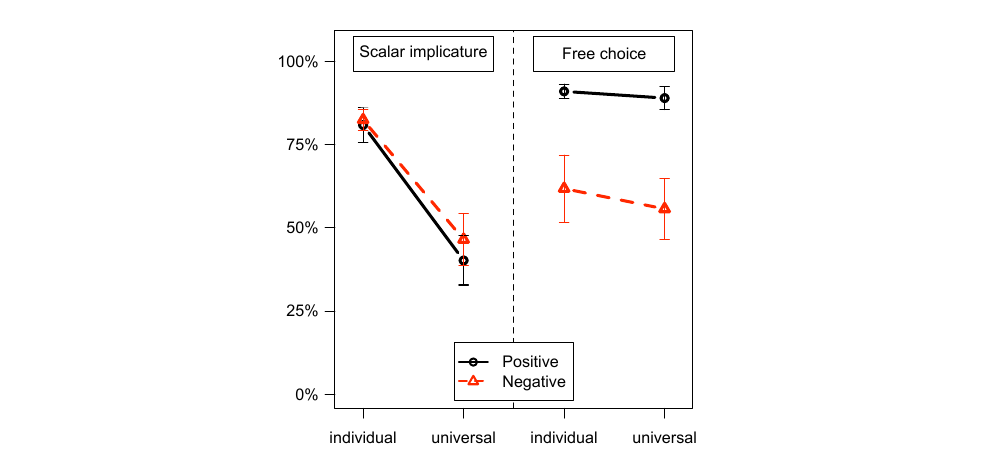
Figure 4 Actual results – mean rates for each inference (% of the line filled) Positive = Negative. However, no difference is detected between the pos- itive and the negative configurations. The interaction between environment (positive and negative), and domain (individual vs. universal) is not significant ( F < 1 , n.s.). In fact, the positive and the negative cases look exactly the same. Overall. These results seem to support the globalist approach (see pre- dictions in ( 16